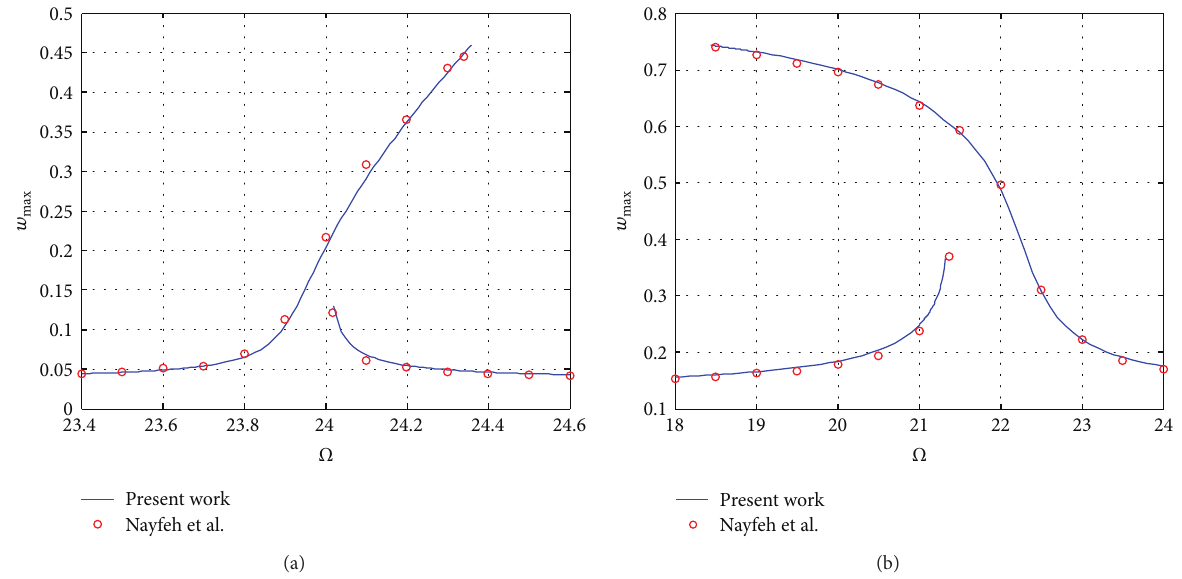
= 2 V, 𝑉 = 0.1 V) and (b) in the softening domain dc ac